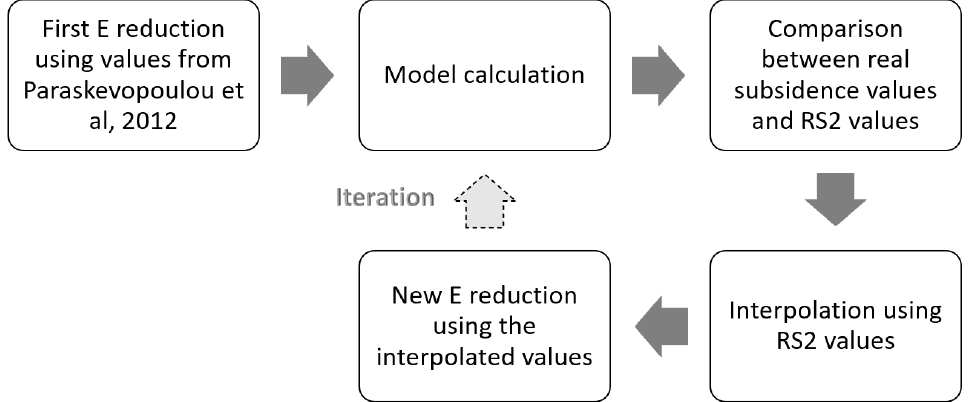
Figure 6. The methodology followe d to define Young’s modulus decrease.